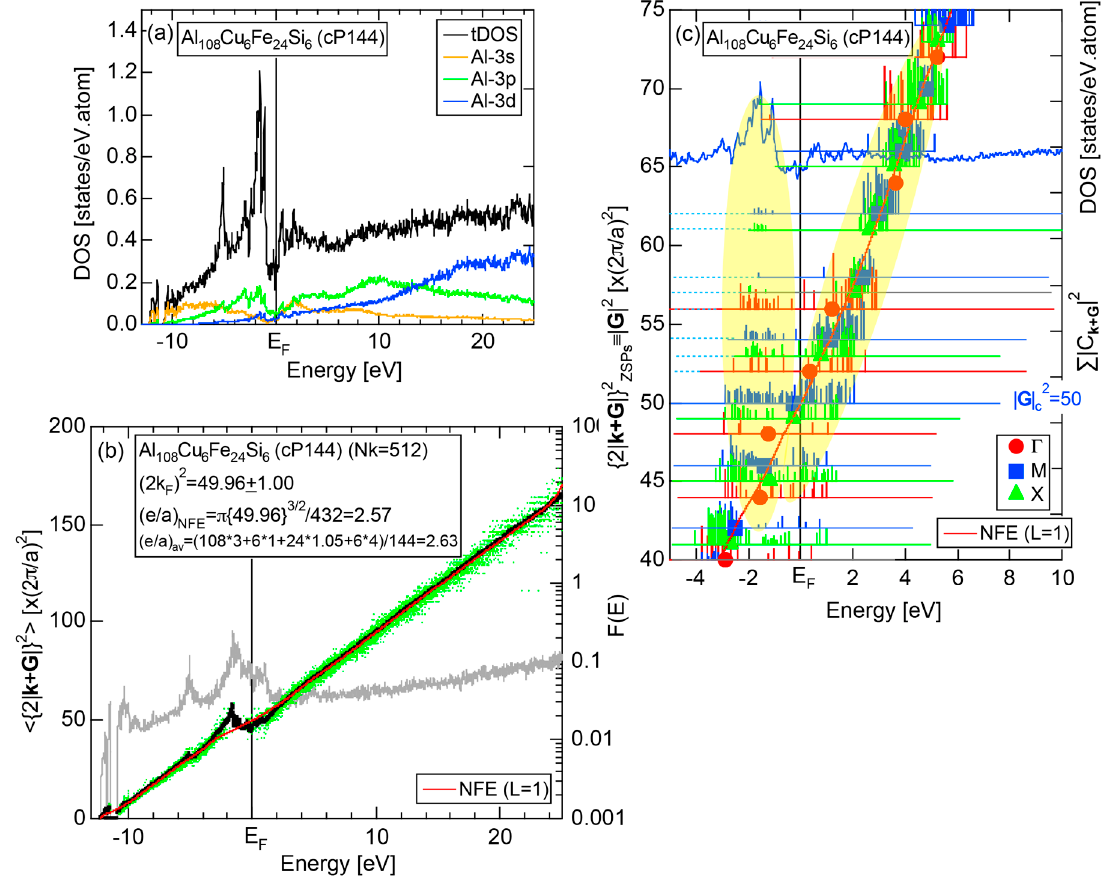
Figure 44. ( a ) Total DOSs and Al-3spd pDOSs; ( b ) Hume-Rothery plot and ( c ) FLAPW-Fourier spectra at symmetry points Γ , M, X of simple cubic Brillouin zone for Al 108 Cu 9 Fe 24 Si 6 (cP144) [11]. Relevant numerical data for MI-type 1/1-1/1-1/1 approximants are summarized in Table 5. Briefly, all MI-type 1/1-1/1-1/1 approximants obey the Hume-Rothery electron concentration rule with e/a = 2.64 on average and | G | 2 = c Table 5. Hume-Rothery electron concentration rule foe MI-type 1/1-1/1-1/1 approximants.